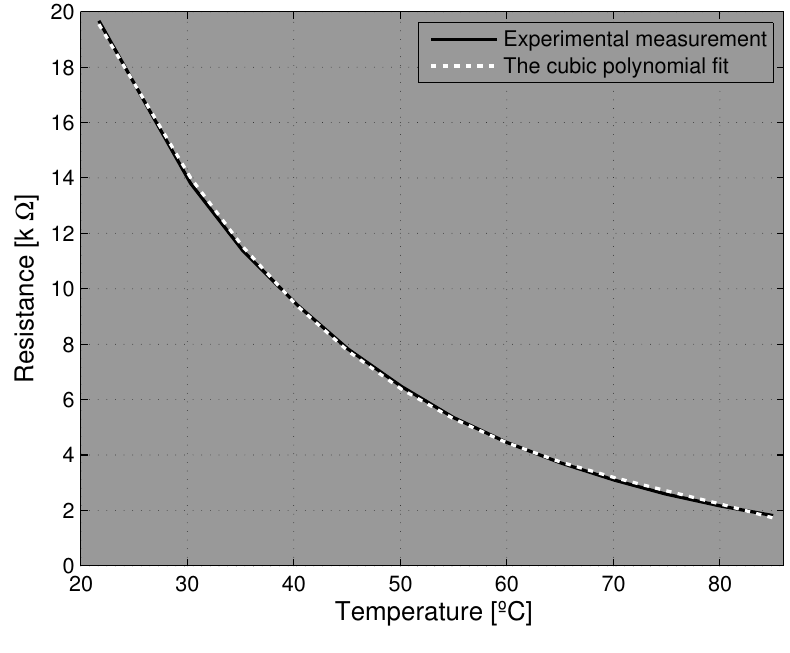
Figure 5. Fuel cell thermistor characteristic. In black line is depicted the experimental measurement using the configuration of Figure 4 and in white line is represented the cubic polynomial fit of Equation